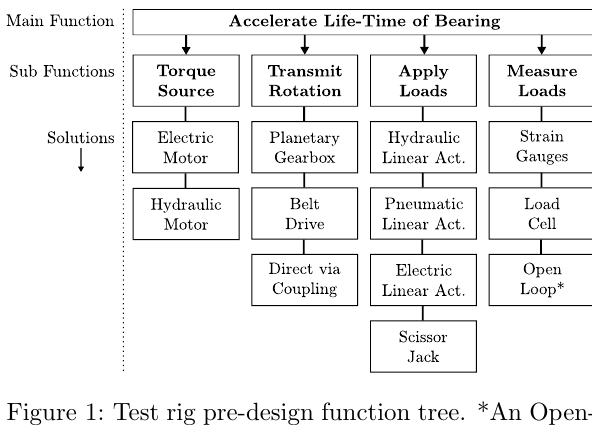
Figure 1: Test rig pre-design function tree. *An Open- Loop force feedback is a feedforward calcula- tion of the assumed forces based on a partic- ular